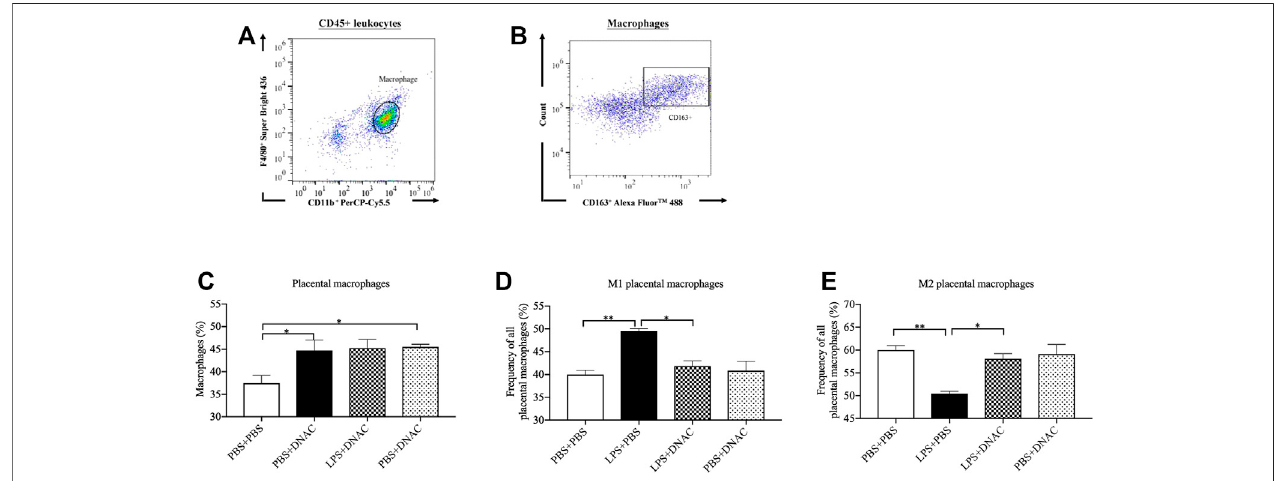
FIGURE 3 | Placenta M1 and M2 phenotype macrophage polarization following exposure to intrauterine in fl ammation and maternal dendrimer-based N-Acetyl Cysteine (DNAC) treatment. At embryonic (E) day 17, pregnant CD-1 mice underwent a mini-laparotomy in the lower abdomen for intrauterine injection of lipopolysaccharide (LPS). One hour later, dams received intraperitoneally injection of DNAC or phosphate-buffered saline (PBS). Placentas were collected at 6 hpi after LPSorPBSinjection. (A) Theplacentalmacrophageswerefurtheridenti fi edbyF4/80+andCD11b+propertiesonplacentalleukocytes. (B) M2macrophageswas identi fi ed by CD163+ and side scatter sequentially on CD45 + CD11b + F4/80 + macrophages. The ratios of total macrophages (C) , M1 (D) and M2 (E) macrophages in fi ltratedintheplacentawerestaticallycompared betweengroups.PBS+PBS, n (cid:1) 8;LPS+PBS, n (cid:1) 8;LPS+DNAC, n (cid:1) 7;PBS+DNAC, n (cid:1) 6.* p < 0.05;** p < 0.01. Data were reported as Mean ± SEM.